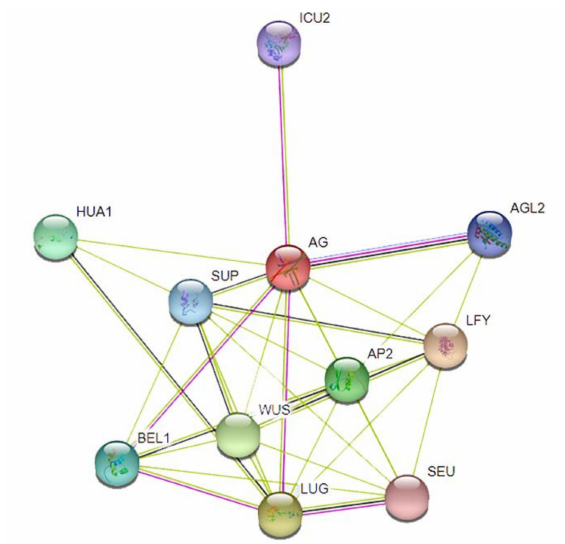
Figure 5. Protein interaction network of PgMADS15 in